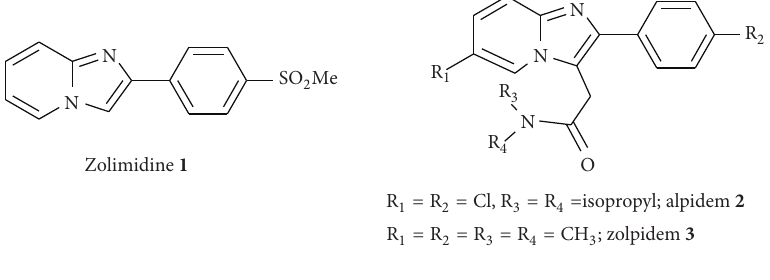
F 1: Structures of some biologically active imidazo[1,2- a ]pyridine